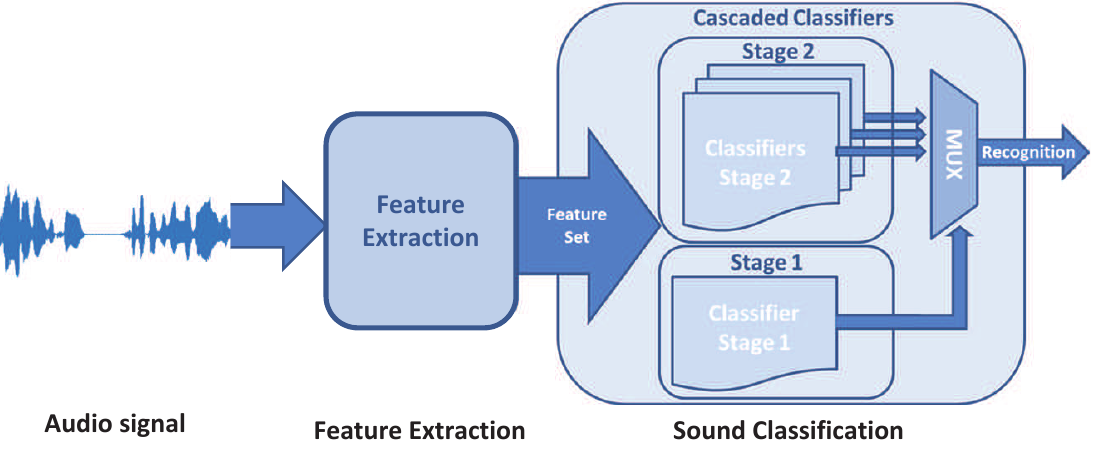
Figure 2. The multi-stage sound classification is composed of two stages, an initial stage performs the broad classification, while a bank of classifiers are used to determine the sound’s category.